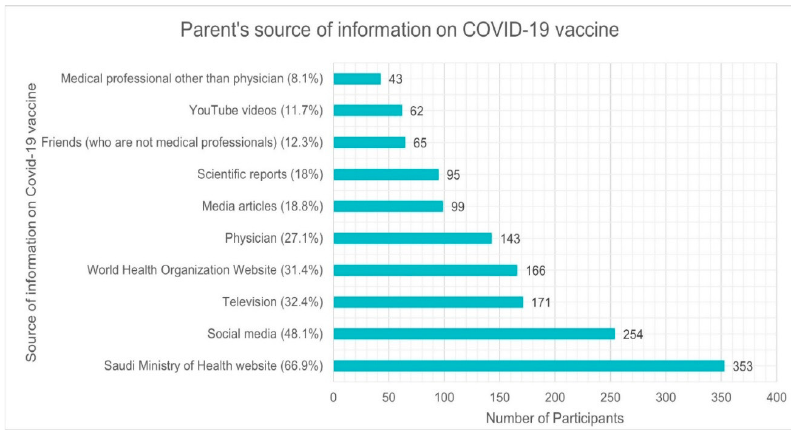
Figure 2. Parents’ source of information on COVID-19 vaccine in